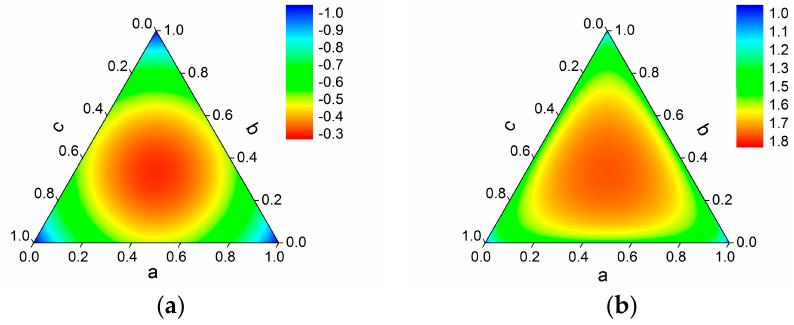
L . Figure 1. The value distribution of the two sparse constraints: ( a ) L L ; ( b ) 1 2 2 2 ; ( b ) L 1/2